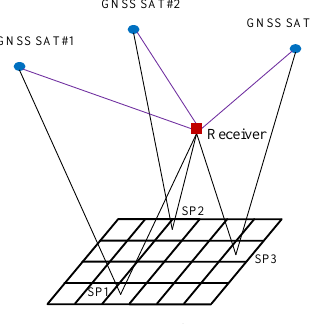
Figure 1: Principle of GNSS altimetry